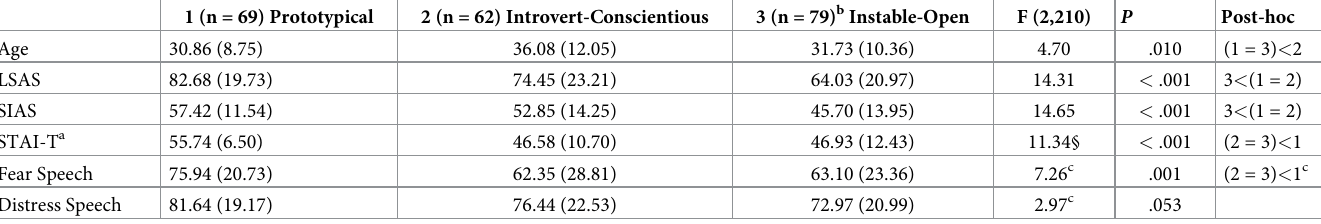
Table 5. Mean values (SD) and ANOVA results on the six profiling variables in the three clusters of social anxiety disorder. 1 (n = 69)